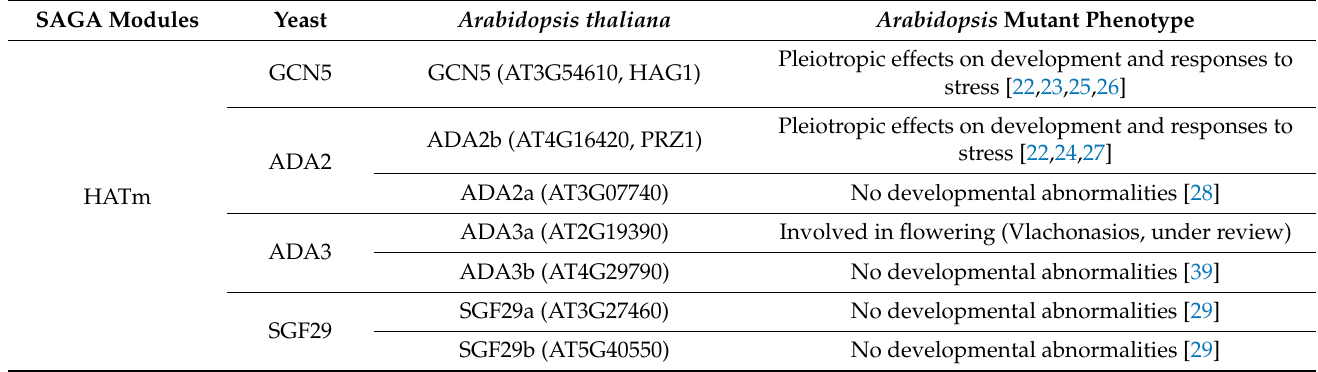
Table 1. Comparison between Arabidopsis and known yeast SAGA